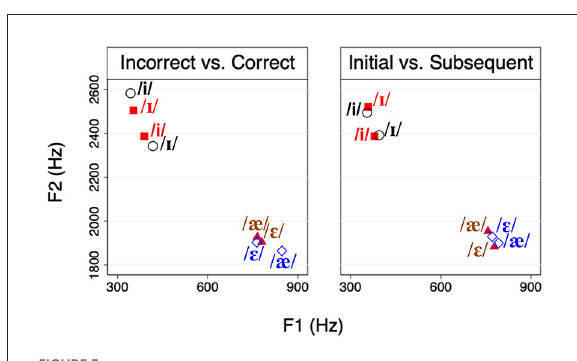
FIGURE3 Contrasting vowels on the F1–F2 plane. Filled markers show the incorrect(left)/initial(right) condition, whereas hollow markers show the correct(left)/subsequent(right)